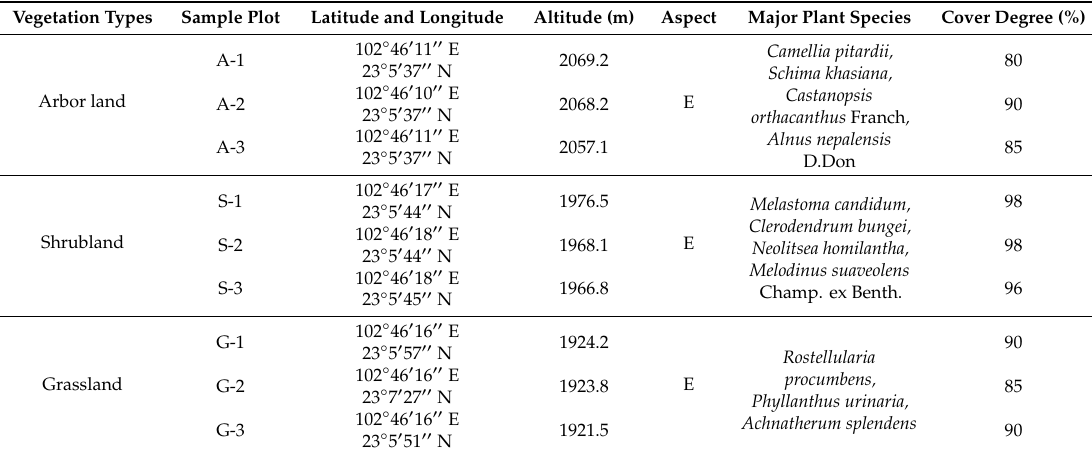
Figure 1. Sketch map of the study area and sample plots. Table 1. The basic information of the sampling plots.